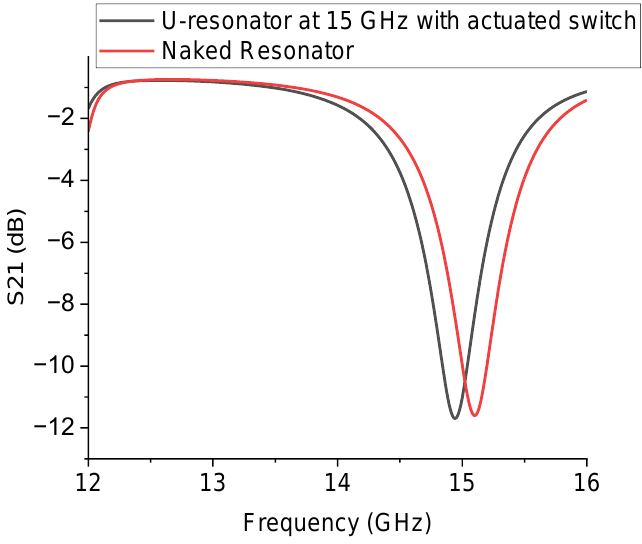
Figure 9. Simulation of the 15 GHz resonator with and without the presence of the RF MEMS switch. No effect is recorded on the matching and only a small shift in the resonance frequency is observed.